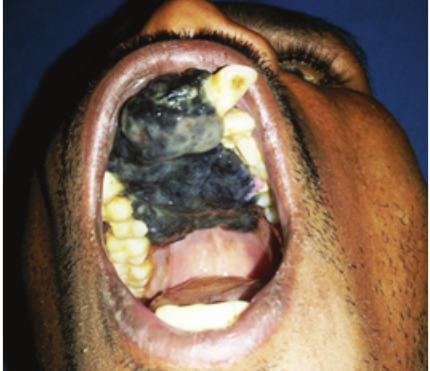
Figure 2: Exophytic growth covered entire hard palate.